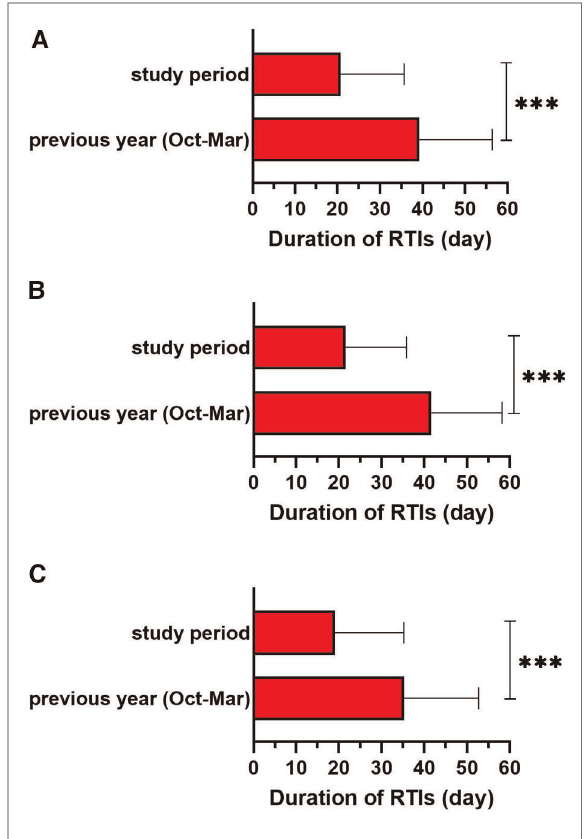
FIGURE 2 Sub-analysis of duration of respiratory tract infections (RTIs) in the study period compared to the same period of the previous year (october – march) in ( A ) whole subgroup of children ( n =624), ( B ) in children under 4 years old ( n =390) and ( C ) in children over 4 years old ( n =234). Data from Slovenia, Croatia, Bosnia and Herzegovina, and Serbia were analysed. *** p